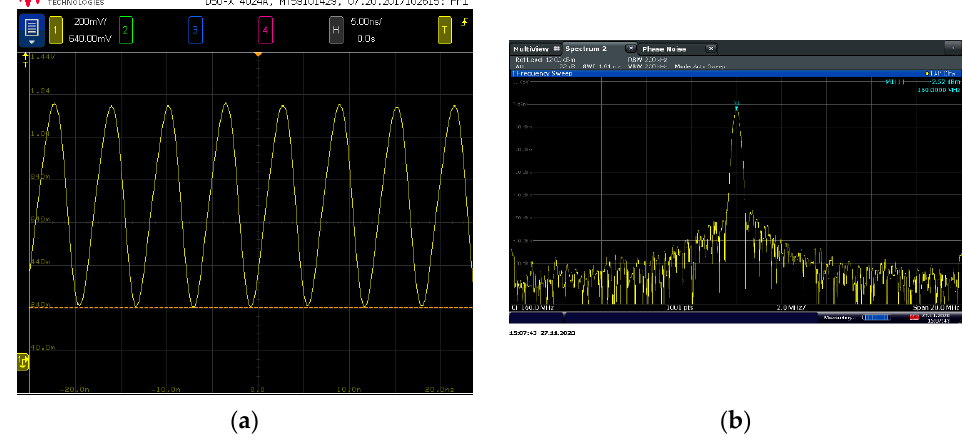
Figure 15. The output waveform and spectrum of 160 MHz. ( a ) The waveform; ( b ) the spectrum.